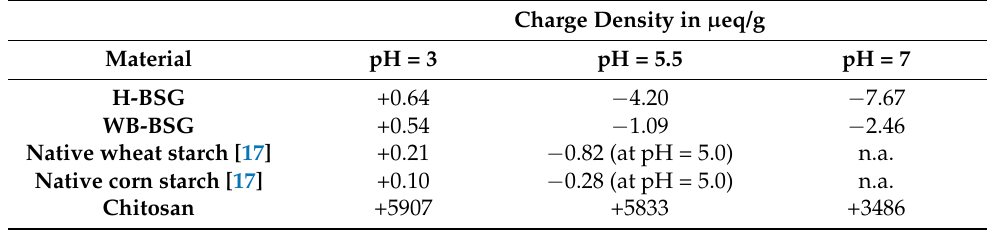
Figure 4. Streaming potential and charge density for H-BSG (red) and WB-BSG (grey). The streaming potential ( a ) was measured as a function of the pH value and the z potential for H-BSG and WB-BSG was thus determined. The charge density values ( b ) as a function of pH are in Table 2. Table 2. Charge densities of BSG and other different biopolymers for comparison.